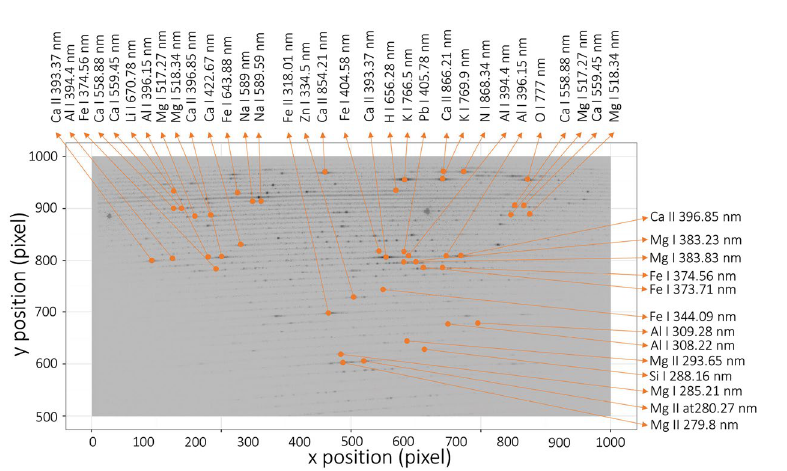
Figure 2. Echellogram of the O131b